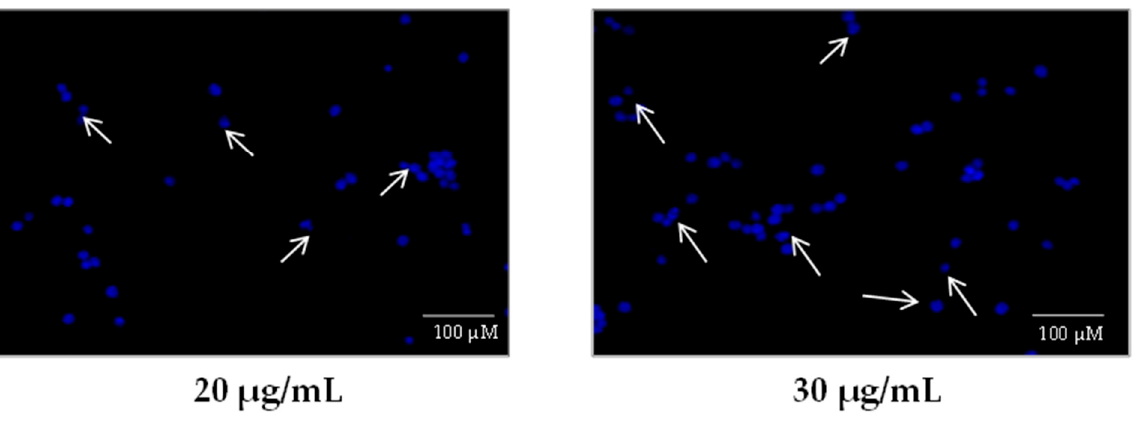
Figure 2. DAPI staining in MCF-7 cell lines. Variation in nuclear morphology induced with PSEM in a concentration-dependent manner, observed under fluorescence microscope. PSEM induced the formation of apoptotic bodies, as shown by arrows. The photographs depicted here are magnified at × 20, and scale bars, 100 µm.